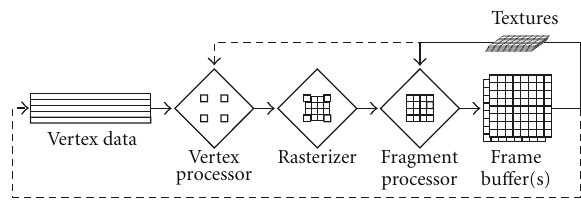
Figure 1: The graphics pipeline. The vertex and fragment proces- sors can be programmed with user code which will be evaluated in parallel on several pipelines. In the latest GPUs these shaders are unified instead of specialized as depicted.